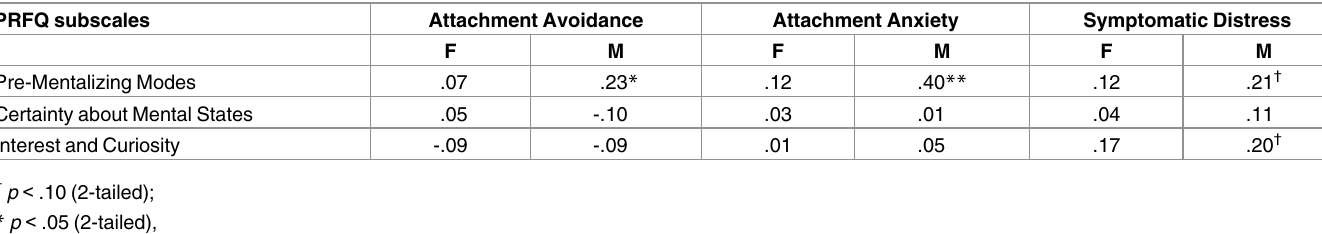
Table 7. Correlations among the PRFQ subscales, symptomatic distress, and maternal attachment in Study 2 for fathers (F) and mothers (M).